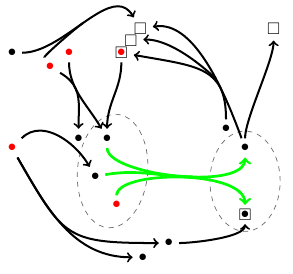
Figure 2. The green hyperedge is negatively